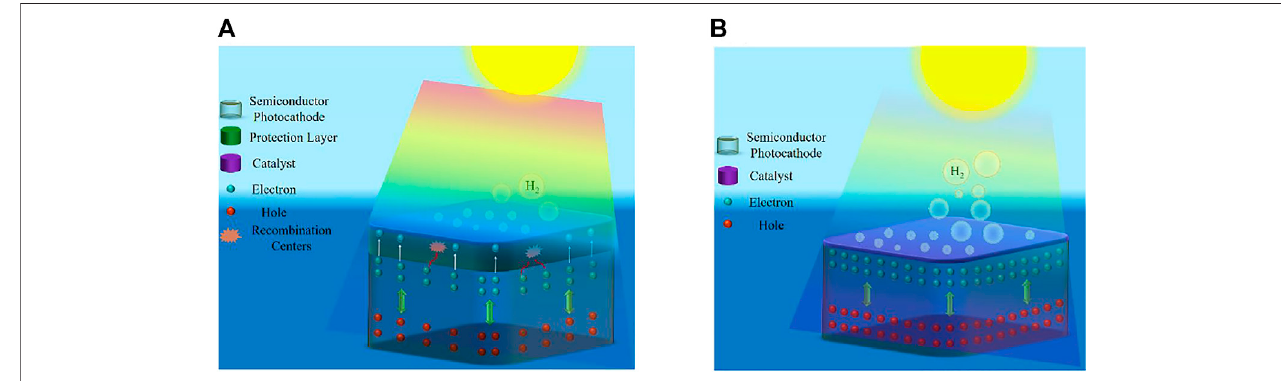
FIGURE 2 | (A) Schematic showing the conventional thick protective layer with a catalyst on top of the light absorber. (B) Schematic showing the photoelectrode with catalyst layer as a protective layer. Reprinted (adapted) with permission from Vanka et al. (2019). Copyright 2019 Royal Society of